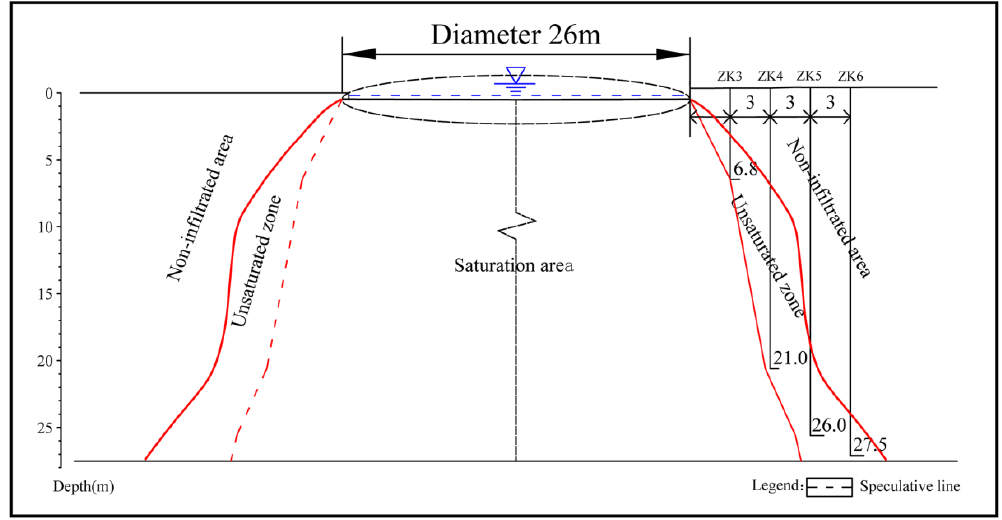
Figure 17. Scope of infiltration zone and saturation zone.